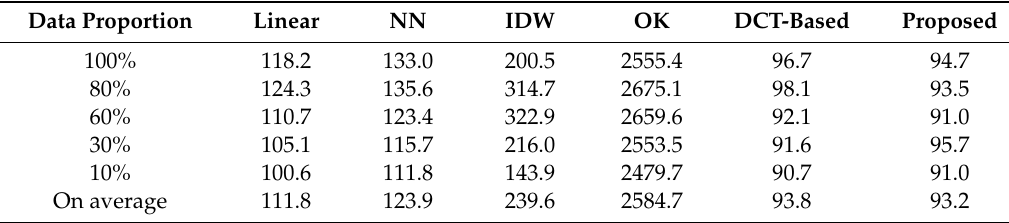
Table 7. Rasterization time (reading the points, interpolation, and writing on disk) of the proposed method and the other interpolation methods on the private dataset (unit: s).